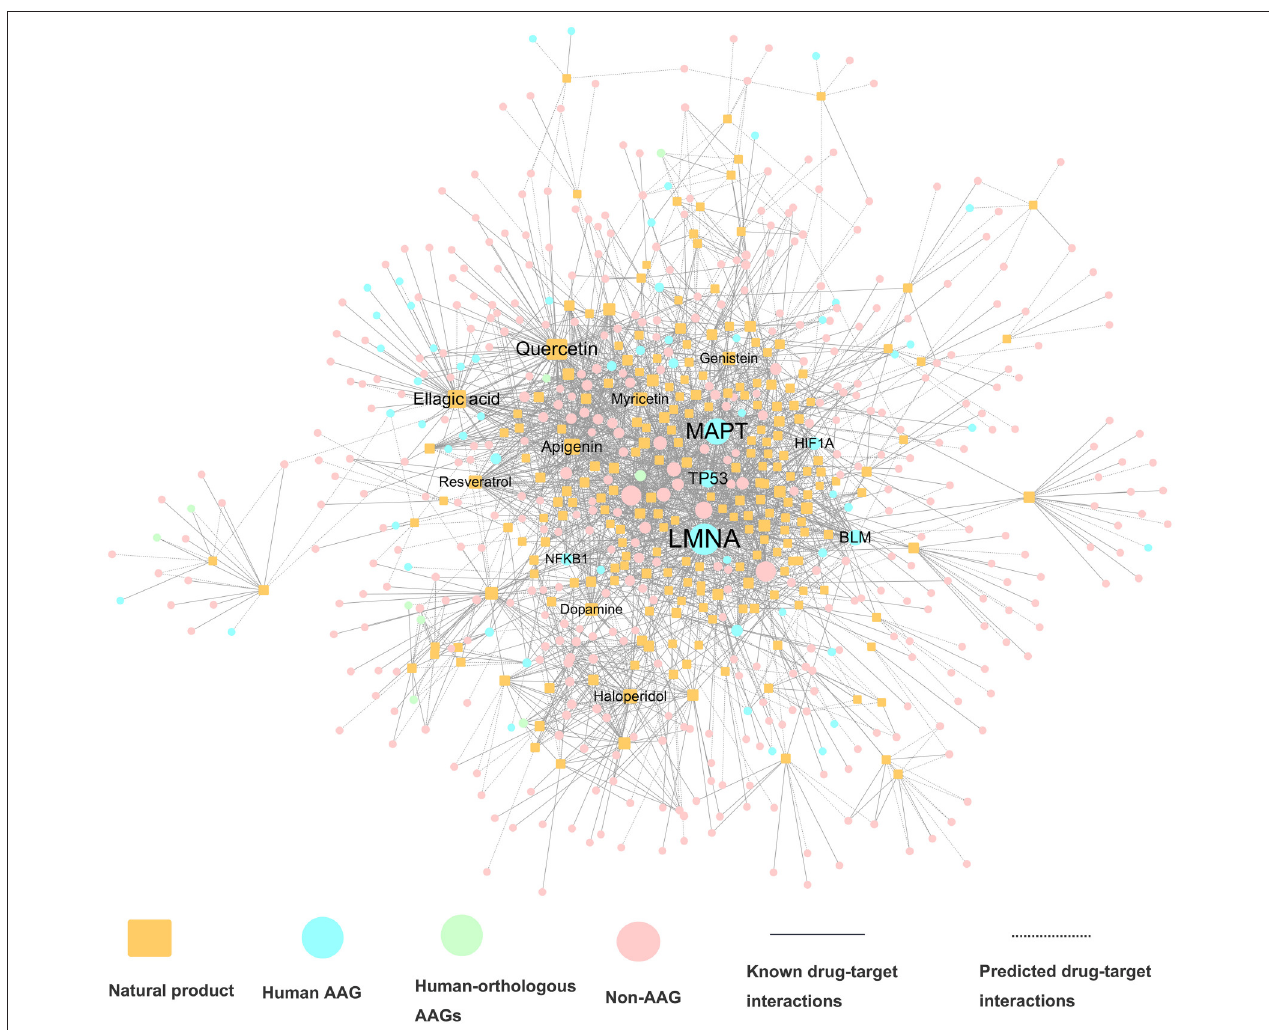
FIGURE 3 | A bipartite drug–target interaction network for FDA-approved or clinically investigational natural products. This network contains 2,408 interactions connecting 224 natural products to 494 target proteins, including proteins encoded by 70 aging-associated genes (AAGs) and 424 non-AAGs. The label font size and node size are proportional to degree